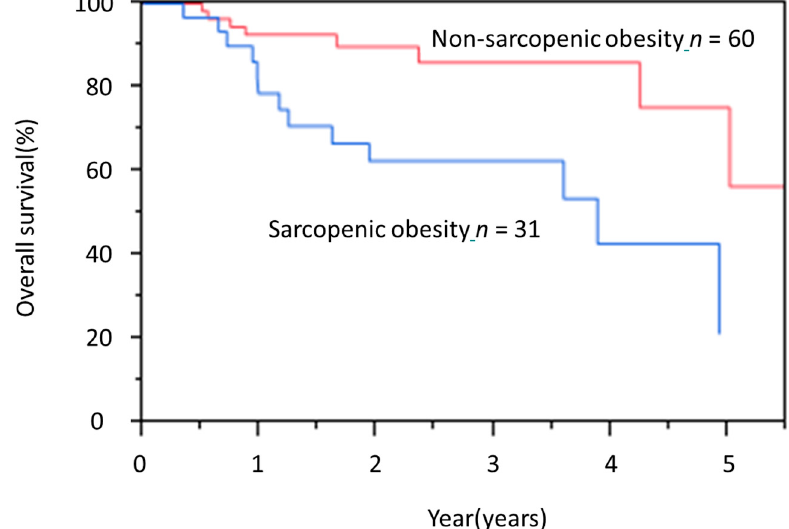
Figure 2. Kaplan-Meier overall survival (OS) curves of elderly patients with and without sarcopenic obesity. HR, hazard ratio; CI, confidence interval.HR, 37.1; 95%CI 1.51–9.88; p < 0.01.